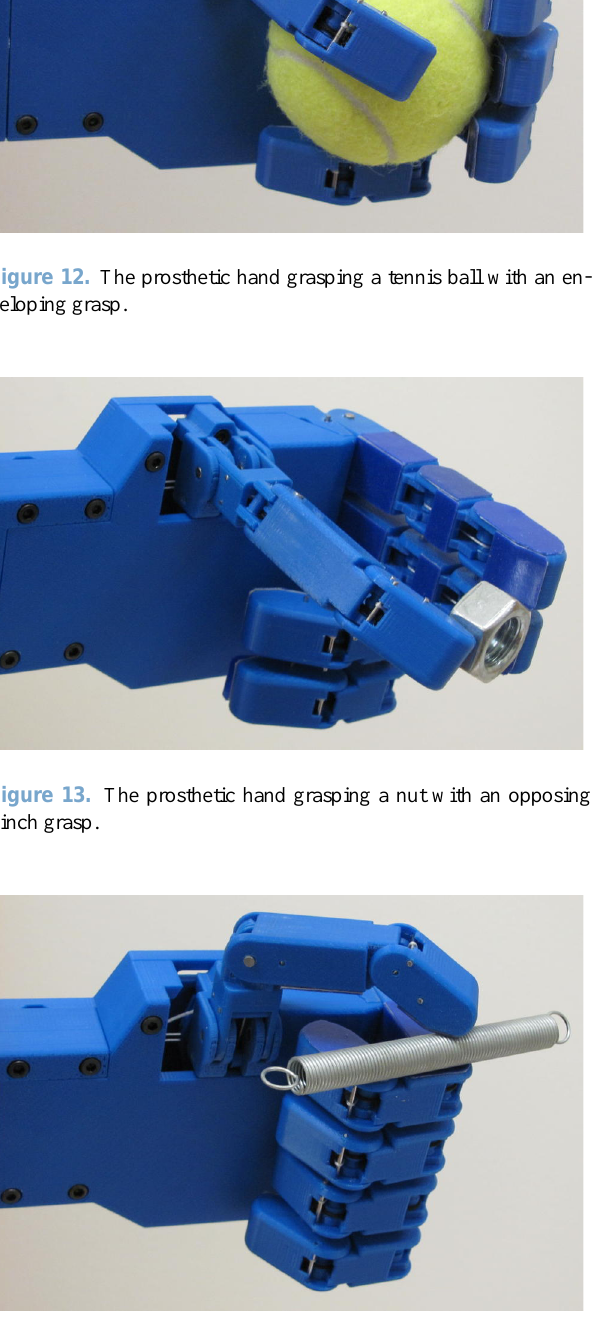
Figure 14. The prosthetic hand grasping a spring with a lateral pinch